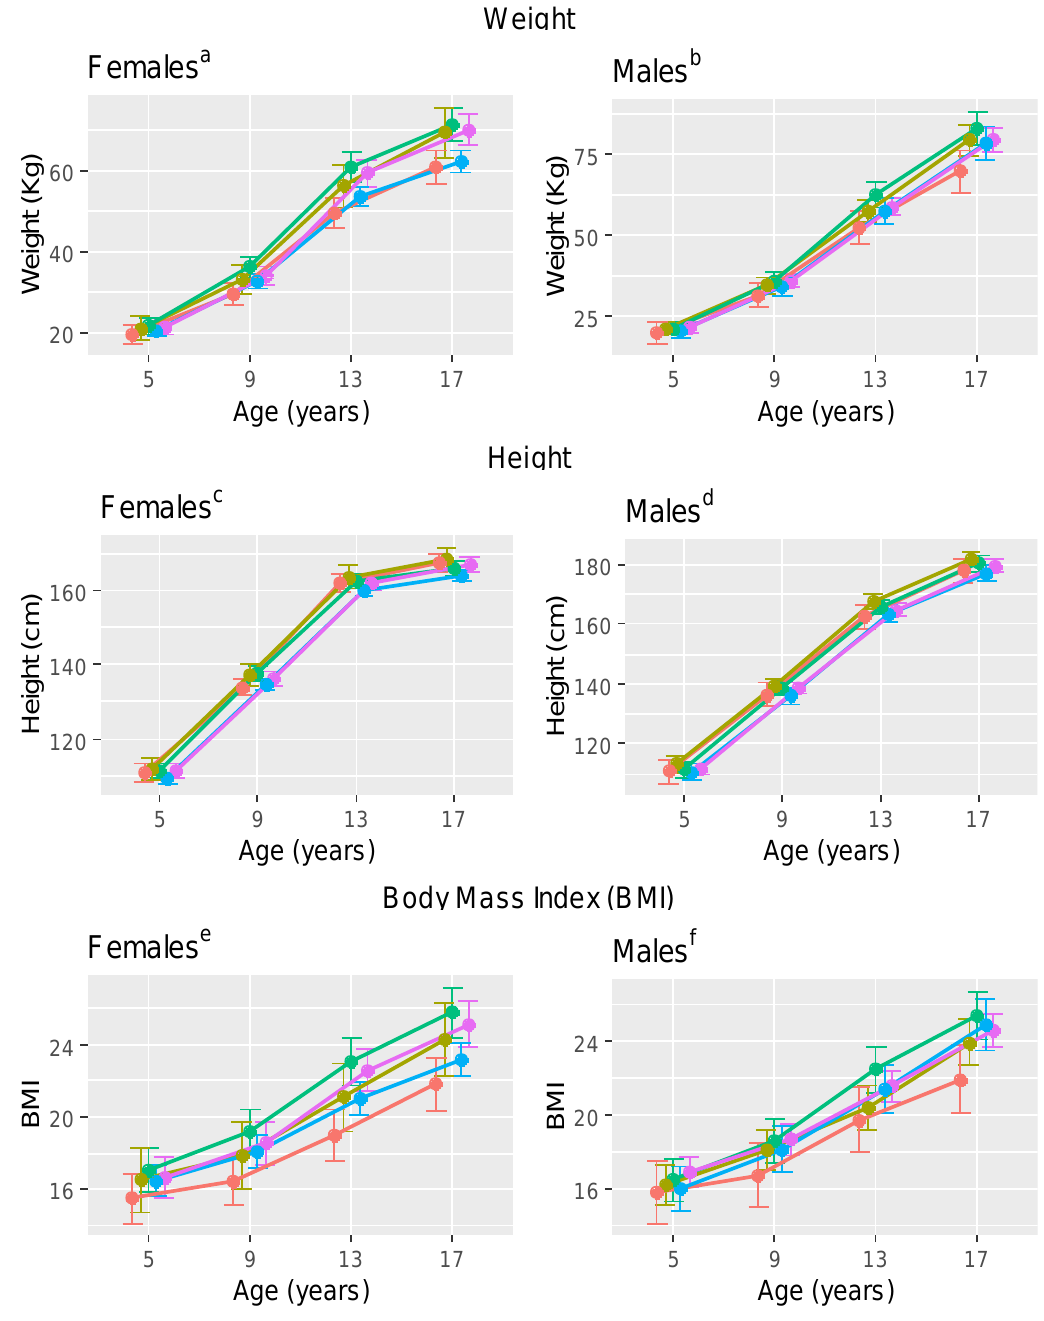
Figure 2. Age 5, 9, 13 and 17-year g mean h (95% CI) anthropometric measures of age 13 to 17 years Iowa Fluoride Study beverage clusters ( n = 369 ; 193 female and 176 male ). Red – 100% Juice Cluster, Gold – Milk Cluster, Green – Water, Blue – Neutral (no dominant beverage) Cluster, Purple – Sugar-Sweetened Beverage Cluster. a,b Model-based mean weight and 95% CIs for females and males in each beverage cluster. c,d Model-based mean height and 95% CIs for females and males in each beverage cluster. e,f Model-based mean BMI and 95% CIs for females and males in each beverage cluster. g All values represent the same approximate age; points are shifted for ease of reading. h Model-based mean estimates.